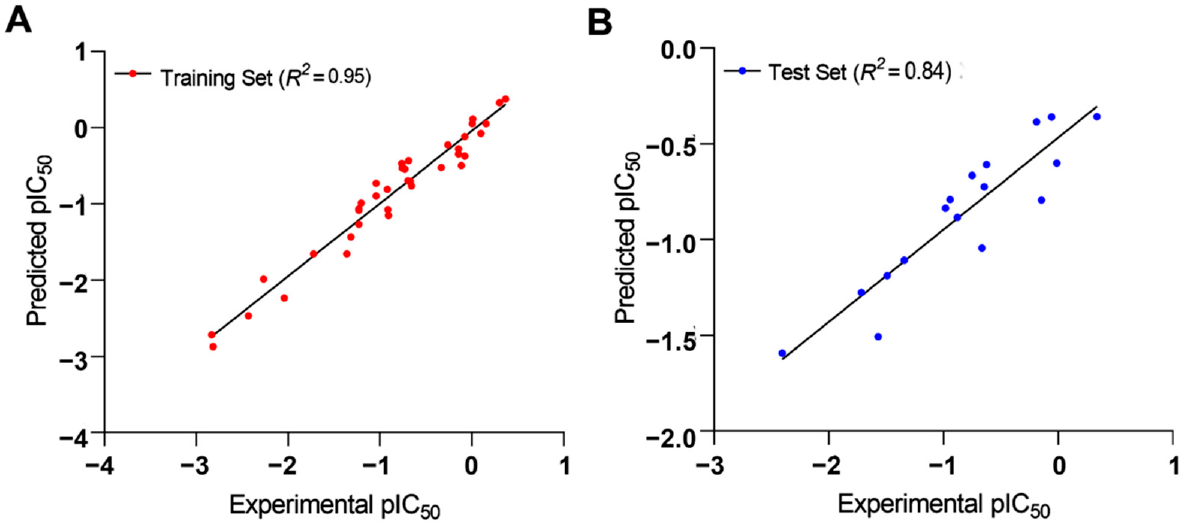
Figure 9. Plots of experimental TLR7 inhibitory activities versus predicted activities of ( A ) training set and ( B ) test set molecules for the 3D ‐ QSAR model.